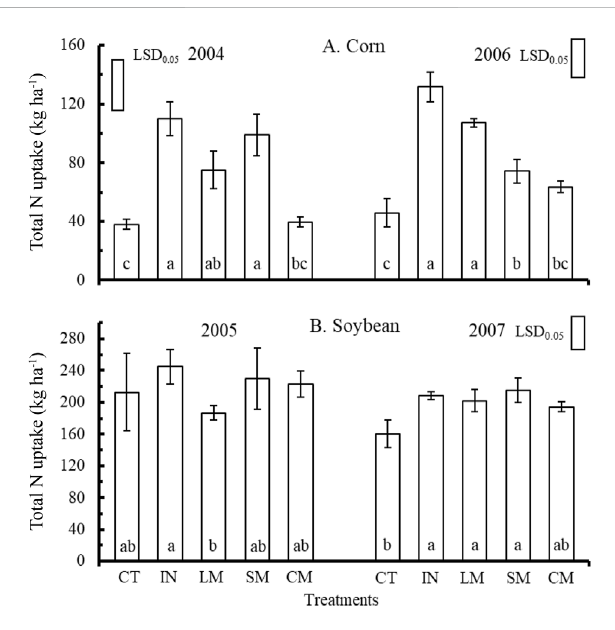
FIGURE 3 Total above-ground plantNuptakeofcornand soybean inrotation from2004to2007.TheabbreviationsofCT,IN,LM,SM,andCMreferred to the control without fertilization, inorganic fertilizer, liquid swine manure, solid swine manure, and composed swine manure, respectively. There was no signi fi cant difference between the bars labeled with the same letter on it within the same year under Fisher ’ s protected LSD test at a signi fi cant level of p ≤ 0.05.